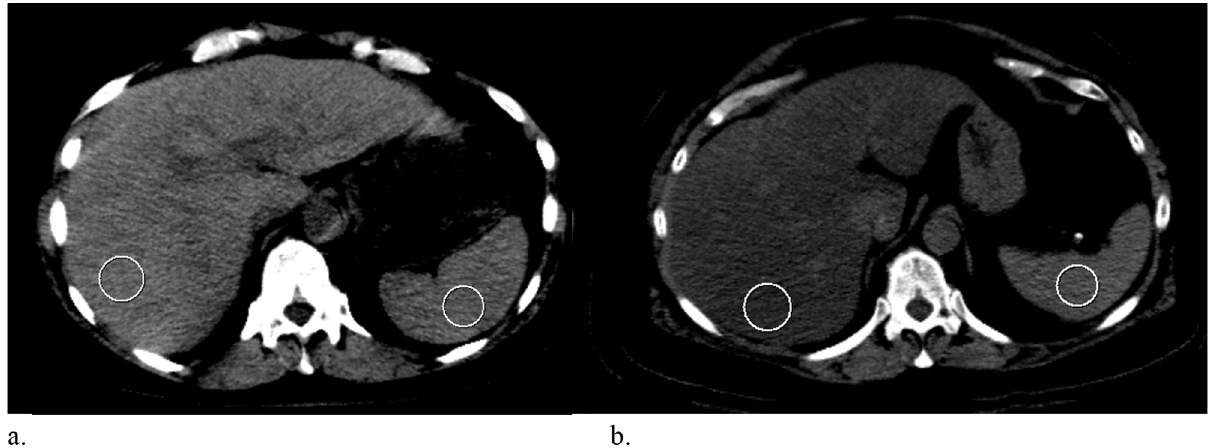
Figure 2. Unenhanced Computed Tomography (CT) scan of the upper abdomen, axial view. Normal liver in a 58-year-old female; liver attenuation is 62 HU, spleen is 55 HU, liver-spleen ratio is 1.1 (a). 64-year-old female with liver steatosis; the liver parenchyma (28 HU) is relatively hypodense compared to the spleen (55 HU), liver-spleen ratio is 0.5 (b). HU: hounsfield units.